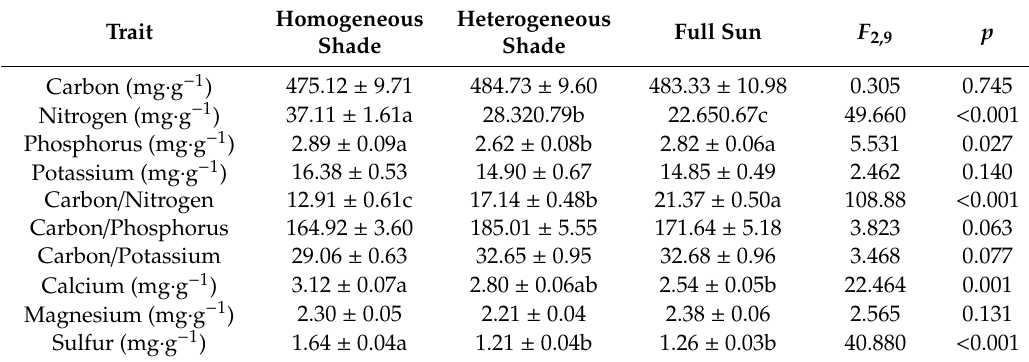
Table 2. Elemental concentrations and stoichiometry of the Cycas micronesica leaves following plant growth in homogeneous 62% sunlight exclusion under a shade screen, heterogeneous 62% sunlight exclusion under a slat-house, or full sunlight. Mean ± SE, n = 4. Homogeneous Heterogeneous Full Sun F Trait Shade Shade